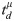
Capacity of networks with MPDP.A: Fraction of pattern where the network generates an output spike within 2 ms distance of target time tdμ, and no spurious spikes. Network size is N = 1000. The desired spikes are learned within ≈ 600 steps. B: Average distance of output spikes to target for the same network size. Training continues even though the desired spikes are generated; however, they are pushed closer to the desired time. C: Average fraction of recalled spikes after 10000 learning blocks for all network sizes as a function of the load. Networks with N = 200 have a high probability to not be able to recall all spikes even for low loads. Otherwise, recall gets better with network size. The thin black line lies at fraction of recall equal to 90%. The critical load α90 is the point where the graph crosses this line. D: Average distance of recalled spikes as a function of the load. The lower the loads, the closer the output spike are to their desired location. E: Critical load as a function of network size for all four learning rules. MPDP reaches approximately half of the maximal capacity.